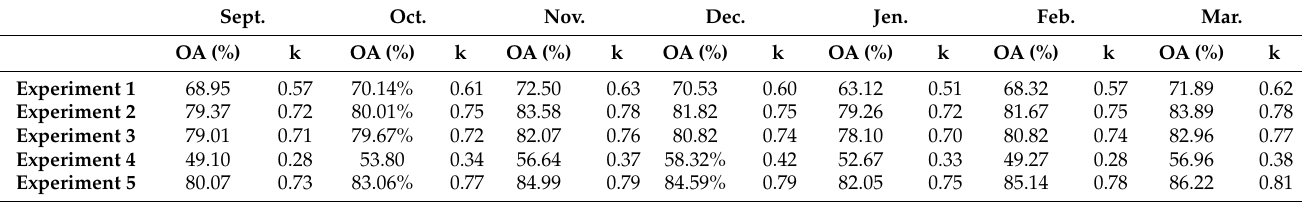
Figure 10. Crop classification result of Tadla Irrigated Perimeter based on Sentinel-1+ Sentinel-2 inputs and RF classifier in the early season. Table 5. Classification accuracy of experiments based on monthly